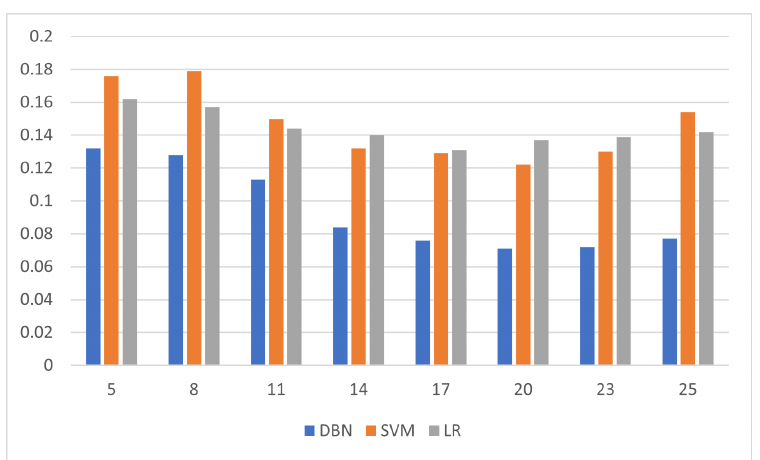
Figure 3. Comparison of the proposed ADBN-IDS with SVM and LR in terms of false positive rate.